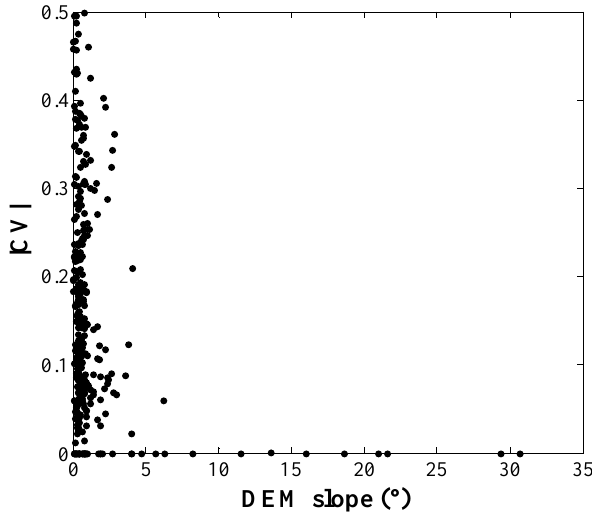
Fig. 6. Scatter plot of DEM slope against absolute coefficient of variance |CV| between the different calibrations for each calibration data point.